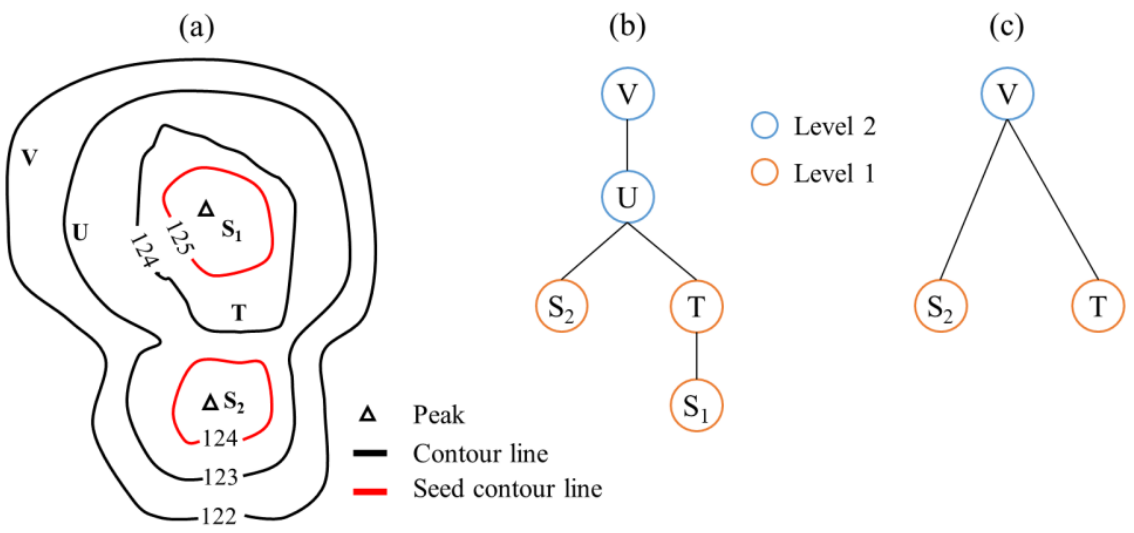
Figure 5. Illustration of localized contour tree algorithm. (a) Contour map of NTL intensity; (b) Regular contour tree; (c) Simplified level of contour tree. Table 3. Parameters of three experiments in Chen’s study.